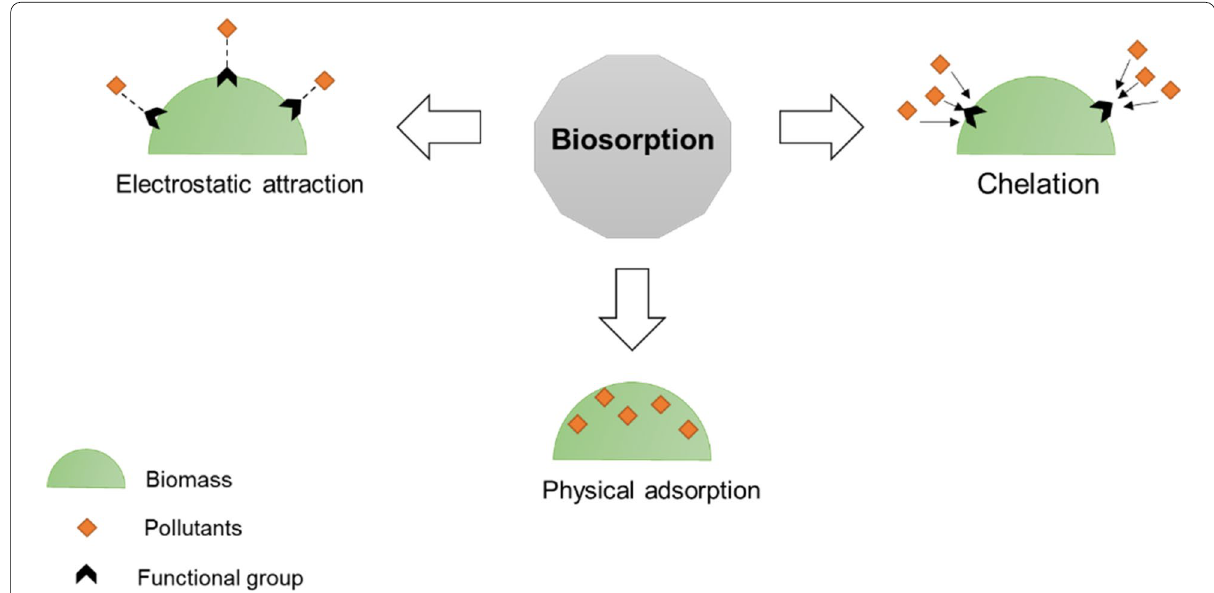
Fig. 3 Adsorption, chelation/complexation and surface precipitation are different processes involved in